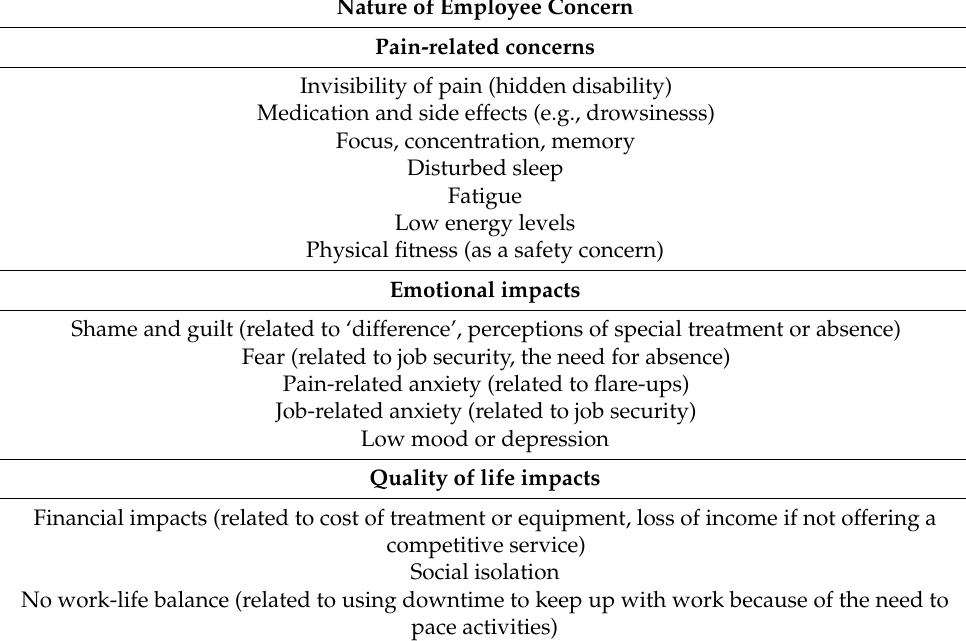
Table 2. Employee concerns and